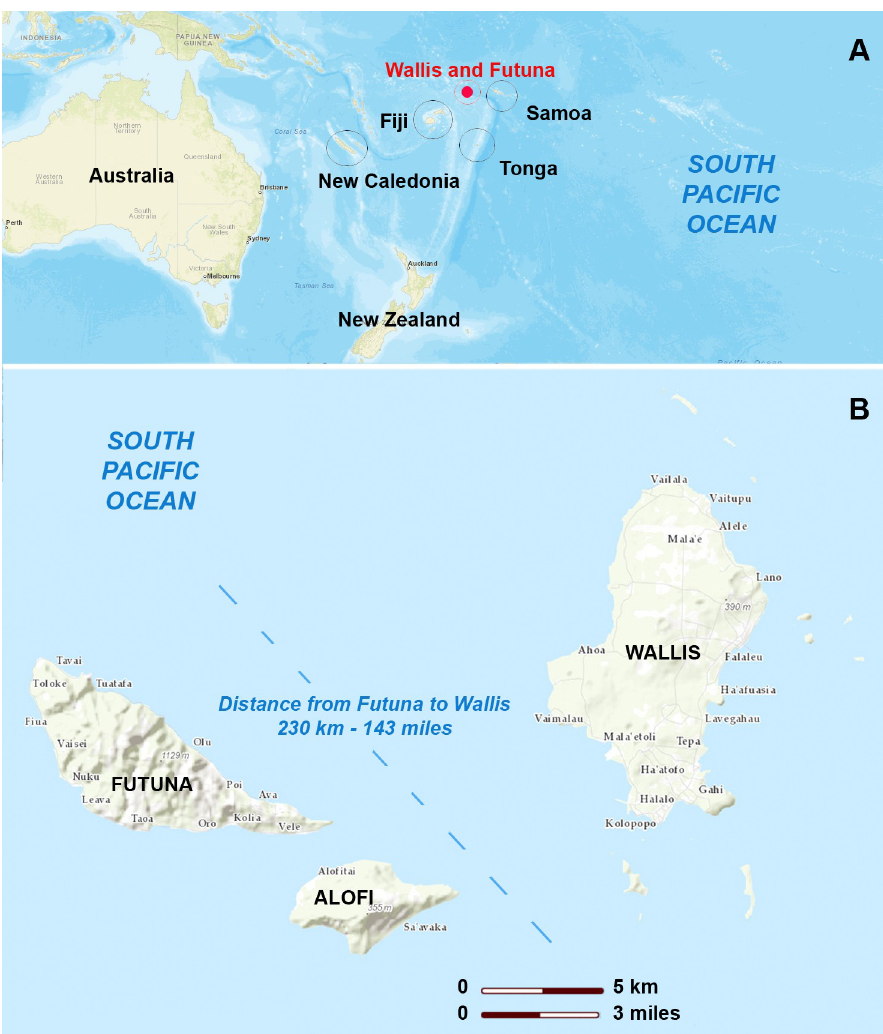
Fig 1. Territory of the Wallis and Futuna Islands. (A) Location of the Territory of the Wallis and Futuna Islands in the South Pacific represented by the red spot. (B) Map of Wallis and Futuna showing the three main islands: Wallis (78 km 2 ) to the northeast, Futuna (46 km 2 ) and Alofi (18 km 2 ) to the southwest. Open source maps from USGS LandsatLook (https://landsatlook.usgs.gov/viewer.html) annotated with Adobe Photoshop